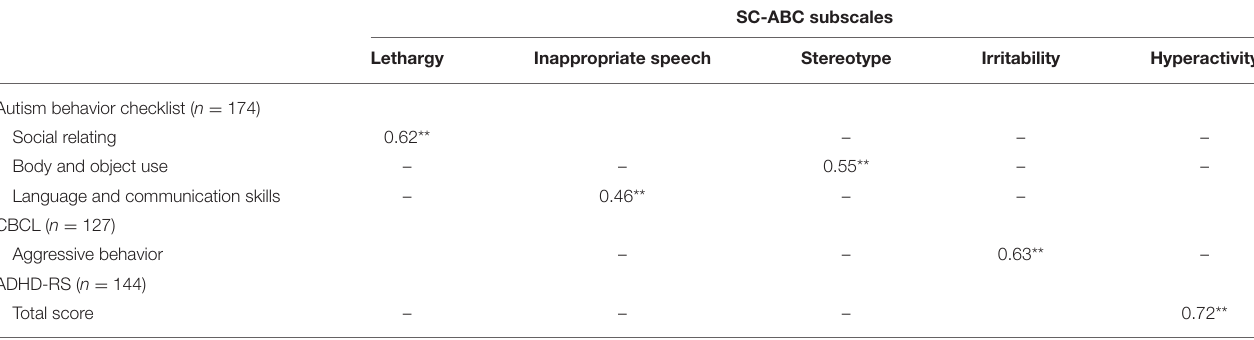
TABLE 5 | Spearman’s rank correlation coefficients for validity (age